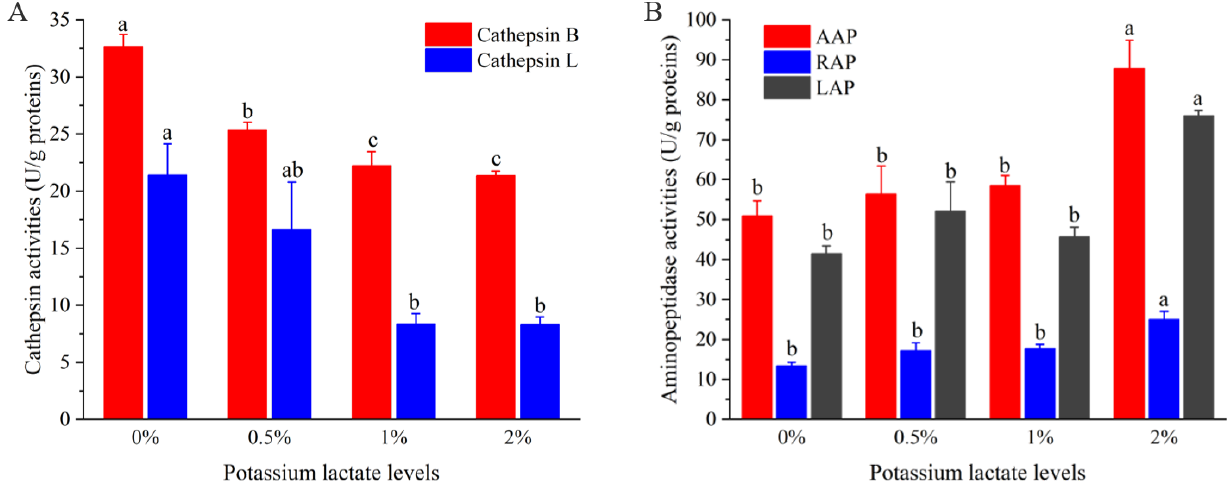
Figure 2. Changes of the activities of cathepsin ( A ) and aminopeptidases ( B ). a–c different lowercase letters mean significant difference among four groups.